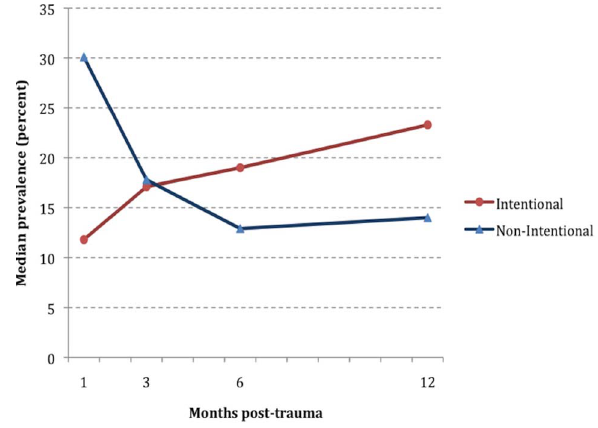
Figure 1. Median prevalence of PTSD in DSM-5-Experiencing categories of intentional and non-intentional trauma (N=14 and 21 studies, respectively). doi:10.1371/journal.pone.0059236.g001 PLOS ONE |